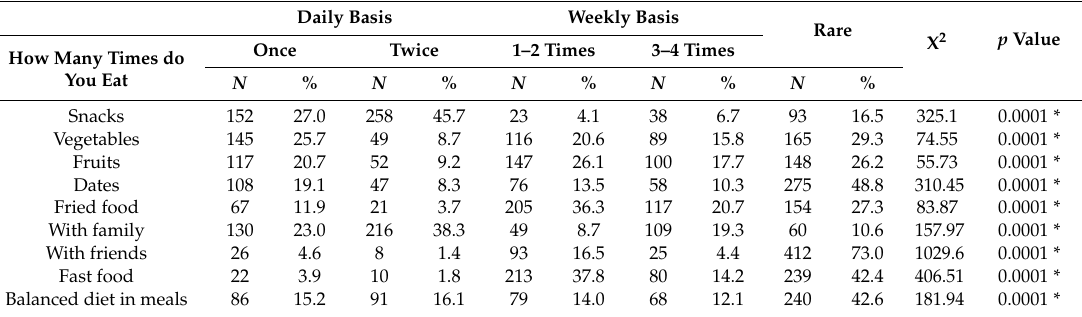
Rare X 2 p Value